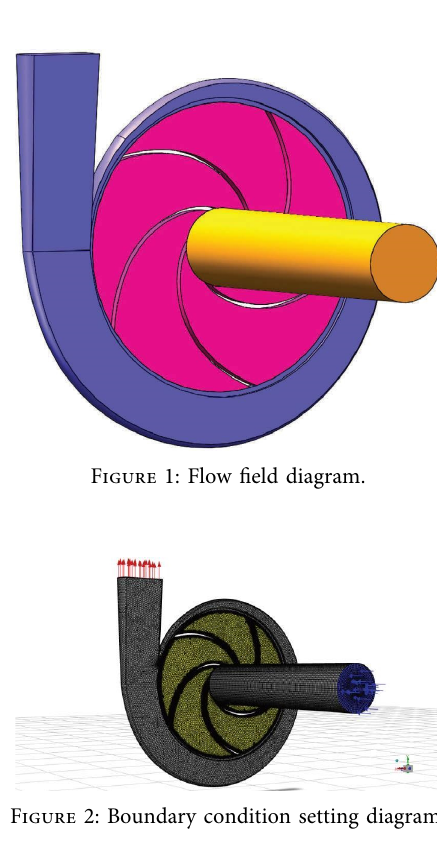
Figure 2. Inlet boundary selection speed inlet: set the value to 2.76 m/s. Outlet boundary selection mass fow rate: the fow rate is set to 13.89 kg/s. Te rotational speed is set to 1440 r/min. Set the impeller blades and back and forward cover plates to the rotating wall; the values are 0 rev/min.